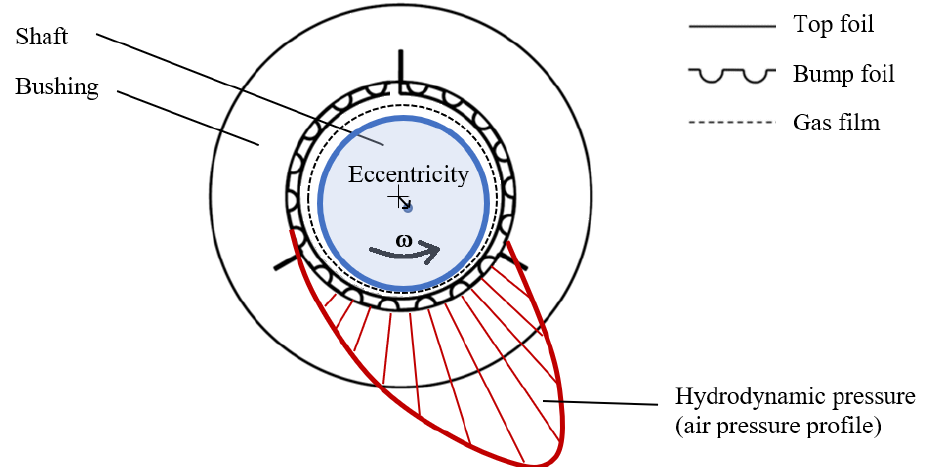
Figure 1. Cross-section of a GFB. Both structural components, i.e., the specialized foils, and a fluidic part (the air) of the supporting layer are shown. There are also the visualized developments of a wedge-shaped gas (air) film and hydrodynamic pressure profiles originated from a relative motion between the rotating part (a shaft’s journal) and a top foil. Note, an eccentricity is a geometric measure used to track of the shaft’s transverse motion. This quantity defines the translation vector for the center of the shaft during operation of the